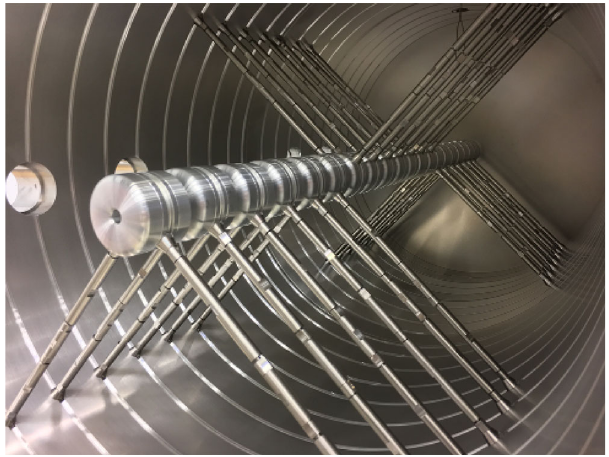
FIG. 21. Aluminium model cavity of scale 1 ∶ 3 with 21 rf-gaps.